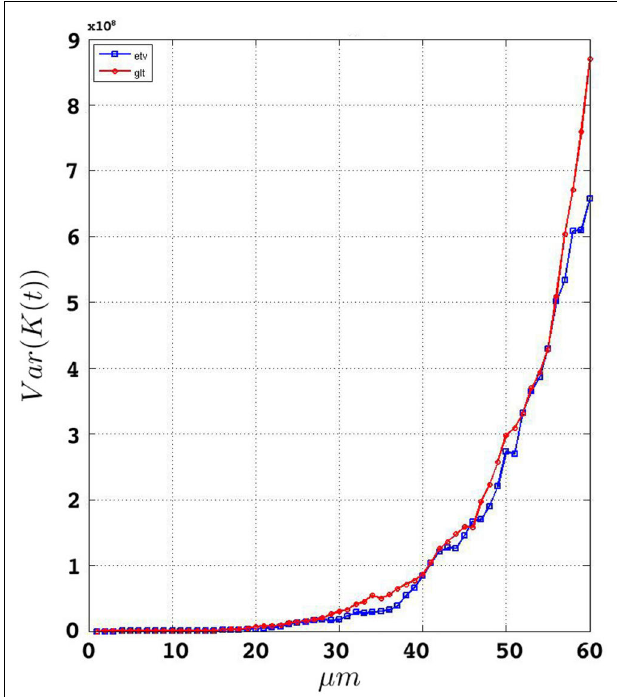
FIGURE 7 | Estimated variance of K(t) (cid:3) for etv and glt .